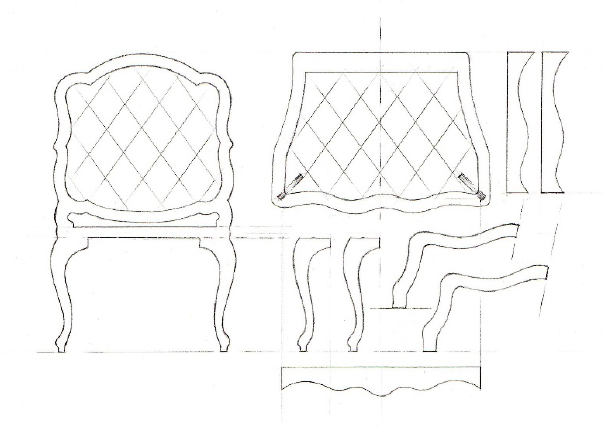
Fig. 1 Curved shape of chair furniture